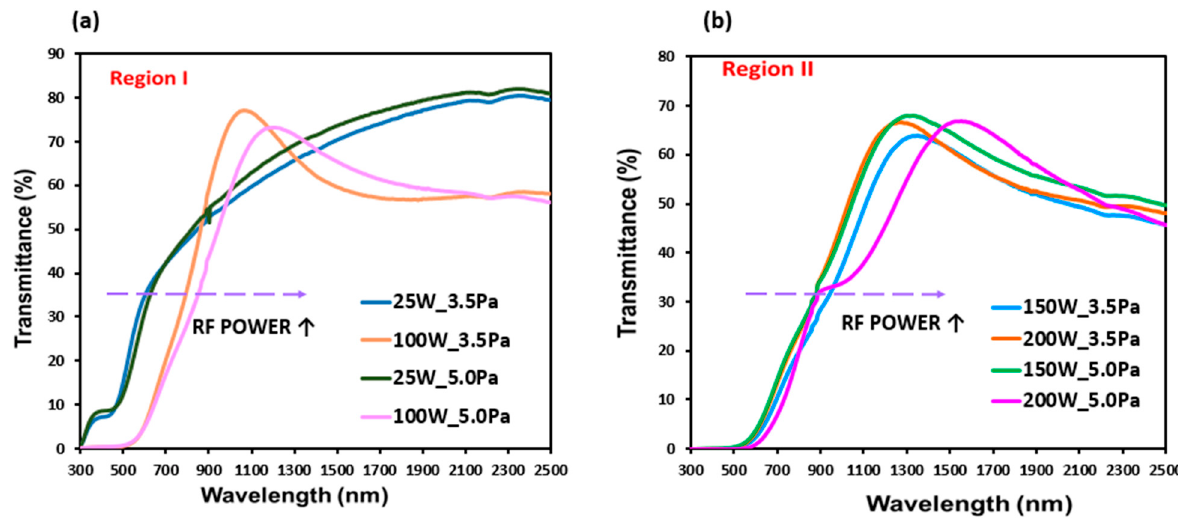
Figure 8. Transmittance spectra of Cu 3 N films prepared at different RF powers and working pressures. ( a ) region I; ( b ) region II.